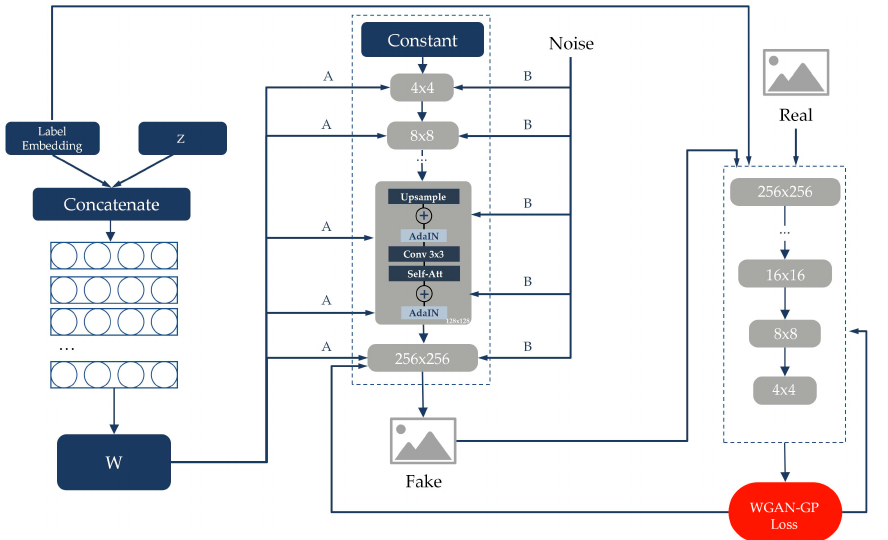
Figure 4. The improved model based on StyleGAN in the study. We input the label embedding of the samples into the mapping network with discriminator; we added the self-attention mechanism in the generator and discriminator 64 × 64 , 128 × 128 and 256 × 256 feature maps.